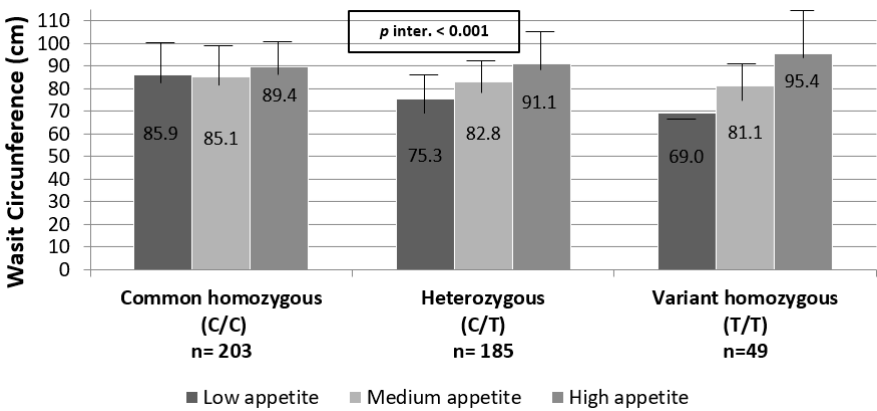
Figure 1. Waist circumference according to CLOCK rs3749474 and appetite classification. p interaction in additive model adjusted by exercise, energy intake, age and gender (Model 3).